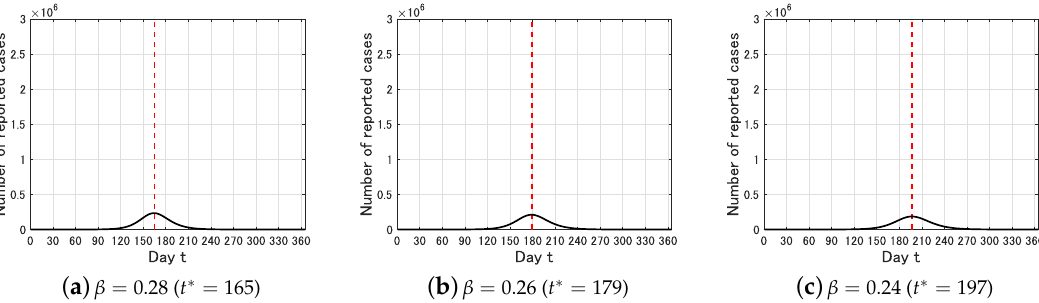
Figure 3. Time variation of the number Y ( t ) of infective individuals who are identified at time t (0 ≤ t ≤ 365) for p = 0.01. The dot lines represent the epidemic peak t ∗